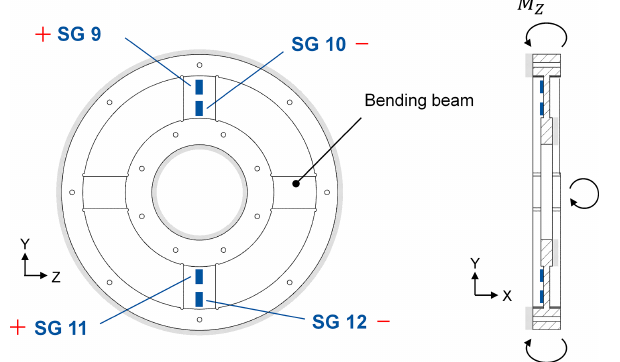
Figure 6. Design principle of the bending